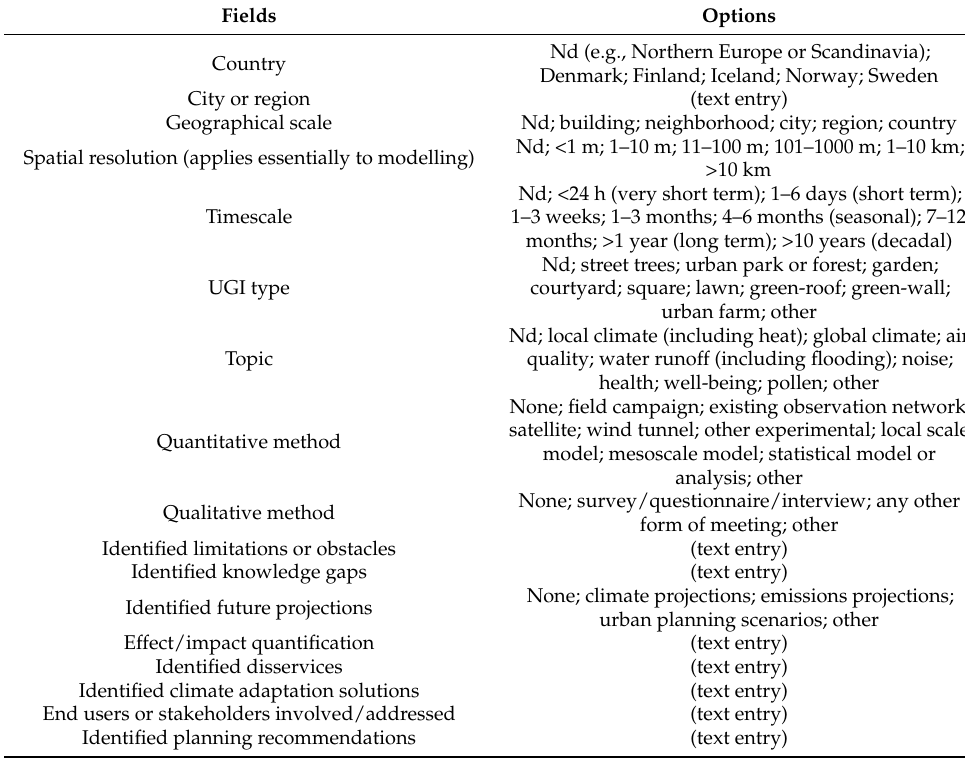
Table A2. Database fields (“Nd” stands for undetermined or